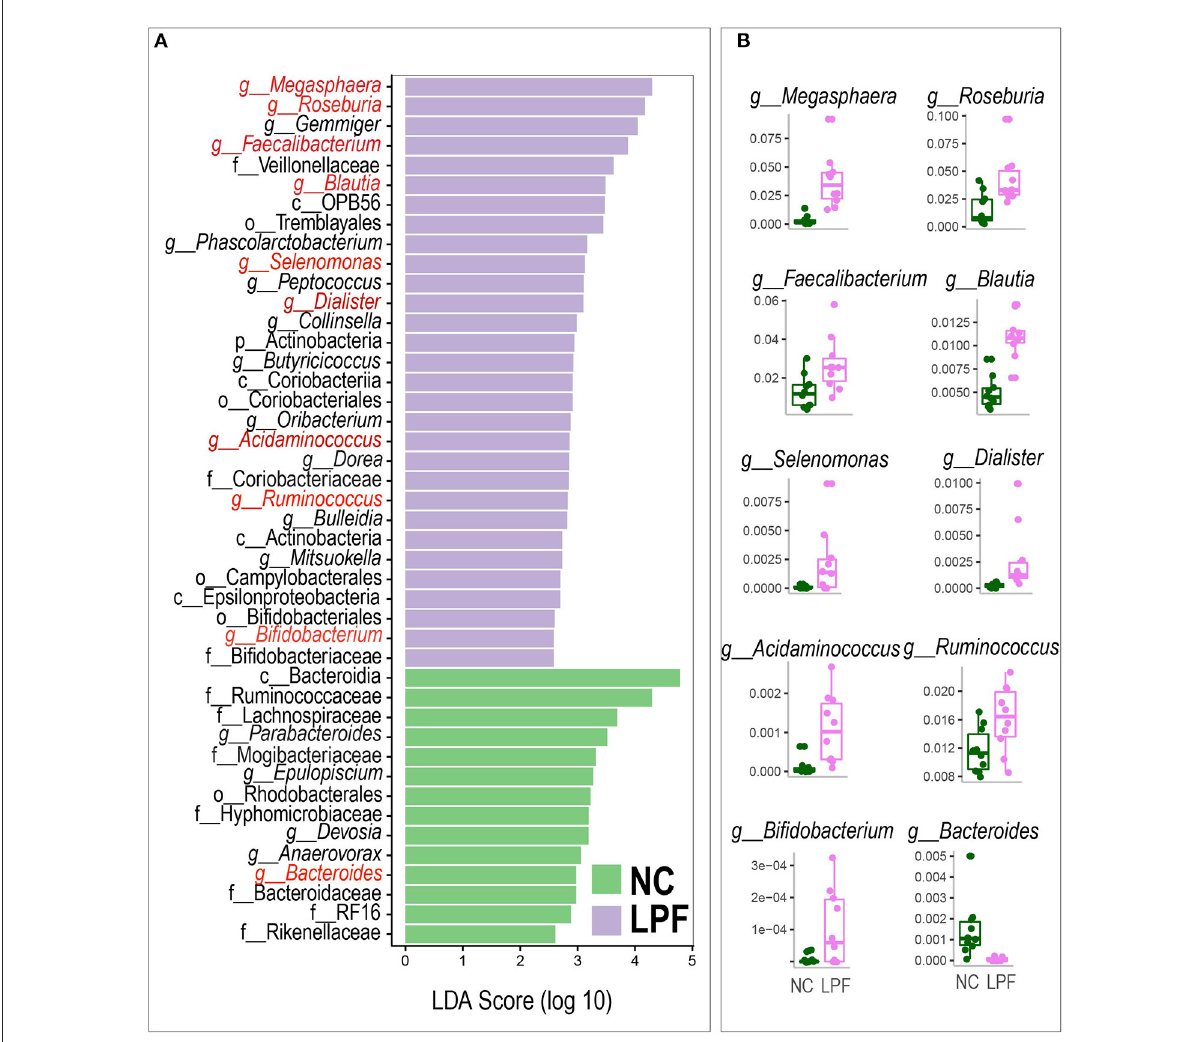
FIGURE5 (A) Linear discriminant analysis effect size (LefSe) of significantly different relative abundant bacterial taxa between groups. (B) Relative abundance of the important bacteria selected by LEfSe. NC diet: basal diet, LPF diet: NC + 10% Lactobacillus plantarum and Pediococcus acidilactici co-fermented